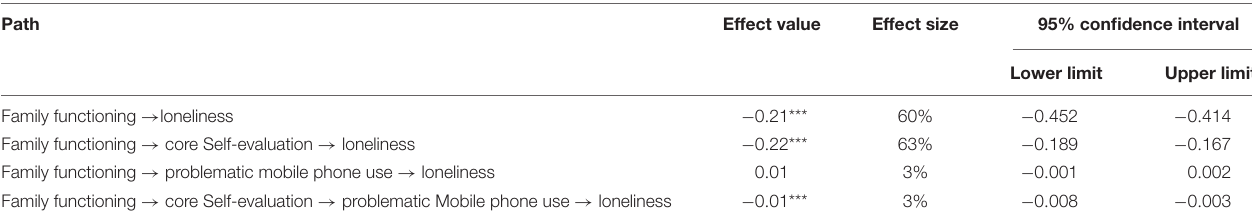
TABLE 2 | Significance test of mediation effect and value of mediation